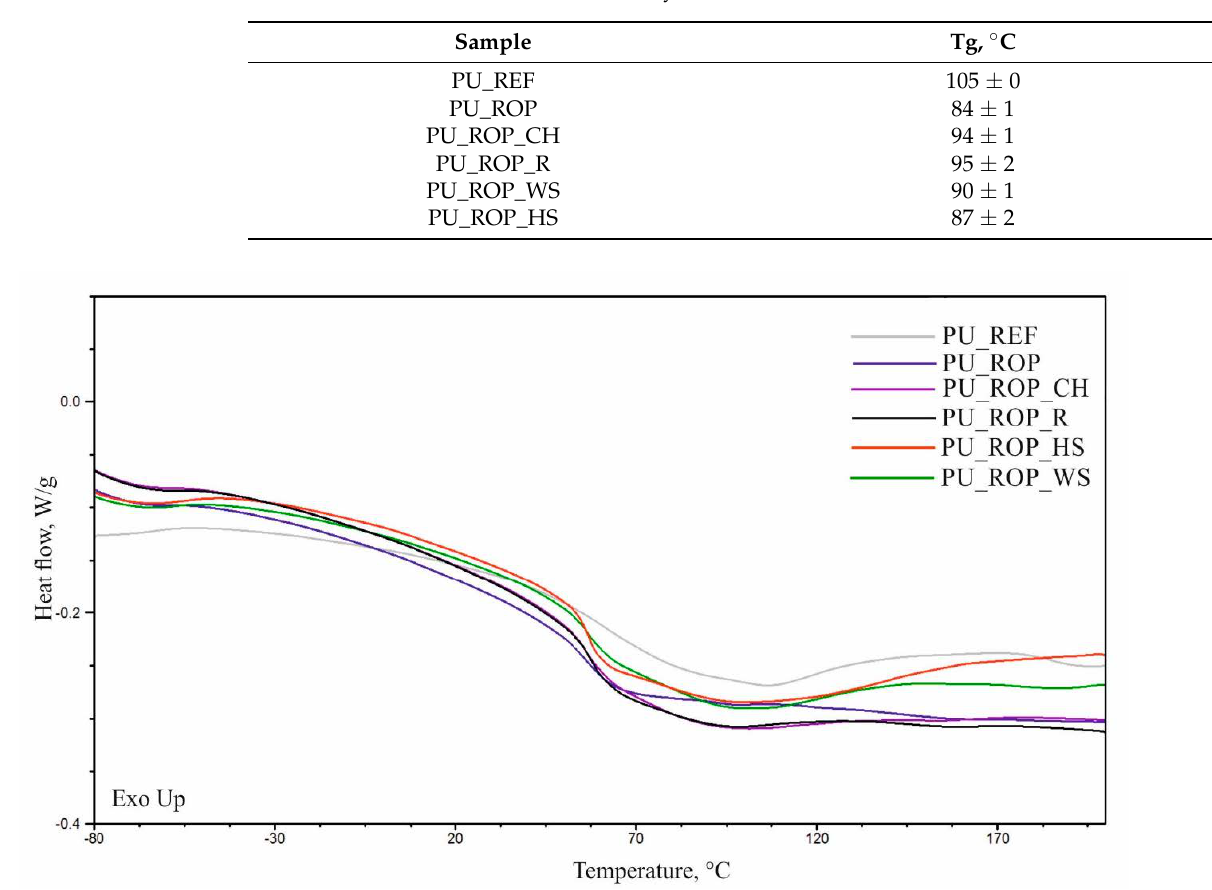
Figure 13. DSC curves (C1) of the developed materials.